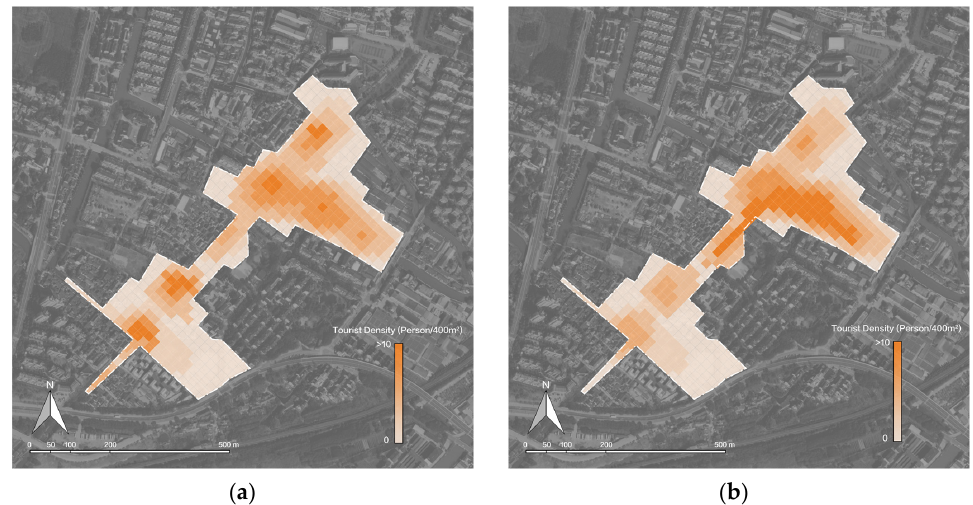
Figure 3. Diagram of the distribution density of visitors in Fengjing Ancient Town (source: